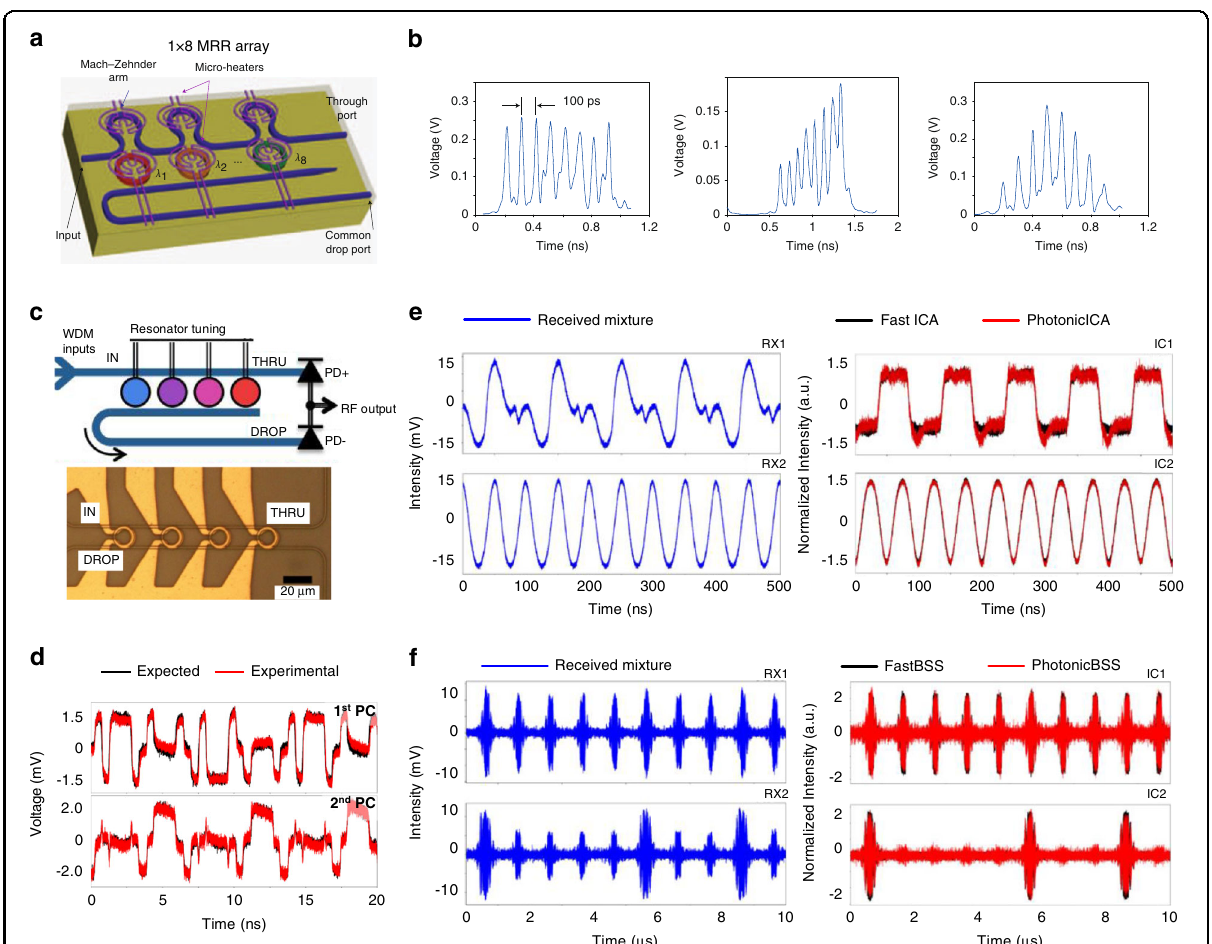
Fig. 7 WDM-MVMs for optical signal processing. a , b On-chip programmable pulse processor employing a cascaded MZI-MRR structure 110 . c Microring weight banks 83 . d Photonic principal component analysis 87 . e Photonic independent component analysis 86 . f Radio-frequency blind source separation 88 . a , b Reproduced from ref. 110 with permission of Springer Nature: Nature Photonics. c Reprinted with permission from ref. 83 © The Optical Society. d Reprinted with permission from ref. 87 © The Optical Society. e Reprinted with permission from ref. 86 © The Optical Society. f Reprinted with permission from ref. 88 © The Optical